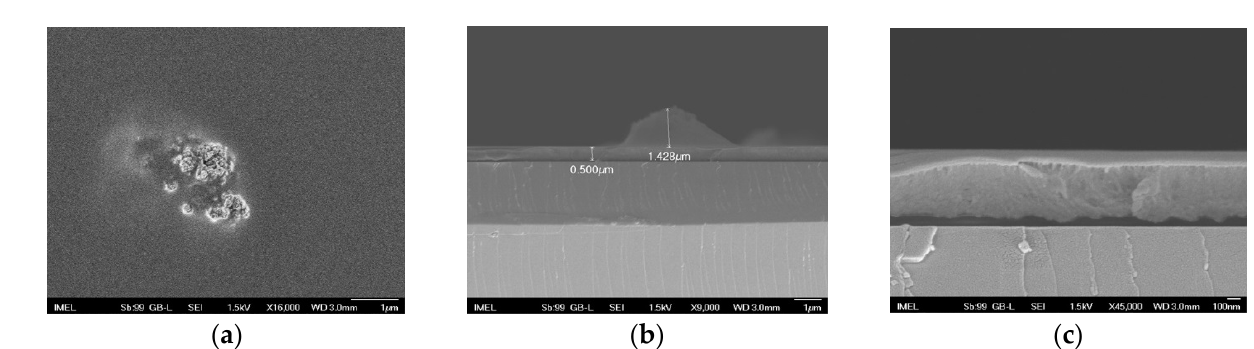
Figure 3. SEM images of sample 1%CuO-1k ( a ) top-down view showing a typical agglomeration of nanofillers found in the film, ( b ) cross-section of one of the nanofiller agglomerates demonstrating their relative size compared to the nanocomposite film thickness and ( c ) cross-section and magnification of the nanocomposite film at a section devoid of agglomerates. Scale bars: 1 µ m in ( a , b ); 100 nm in ( c ).